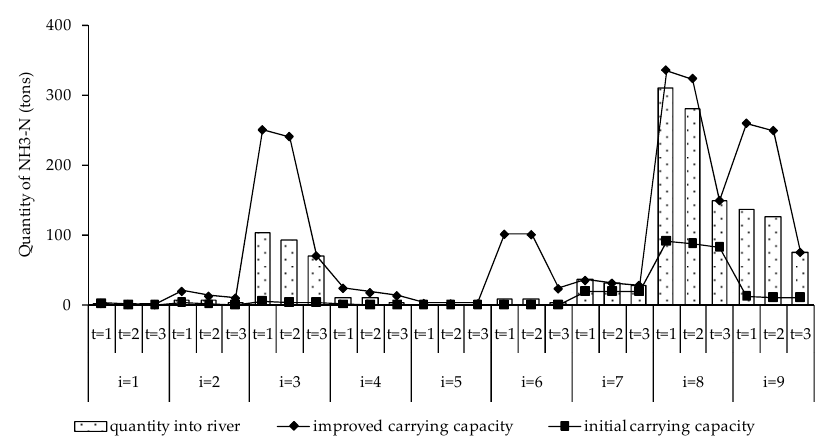
Figure 8. Environmental carrying capacities and pollutants into the Yitong River under the medium flow level.